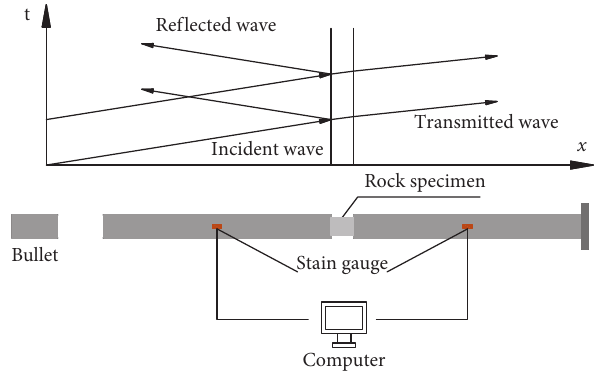
Figure 3: SHPB impact compression test loading process diagram.